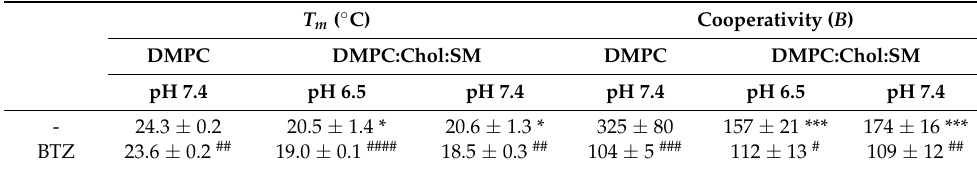
Table 3. T m and B values of DMPC and DMPC:Chol:SM pH 6.5 and 7.4 in the absence or presence of BTZ. Data are given as mean value ± SD ( n = 3). * p < 0.05 and *** p < 0.001 indicate a statistically significant difference when comparing DMPC models with DMPC:Chol:SM models. # p < 0.05; ## p < 0.01; ### p < 0.001; and #### p < 0.0001 indicate a statistically significant difference when comparing models with BTZ